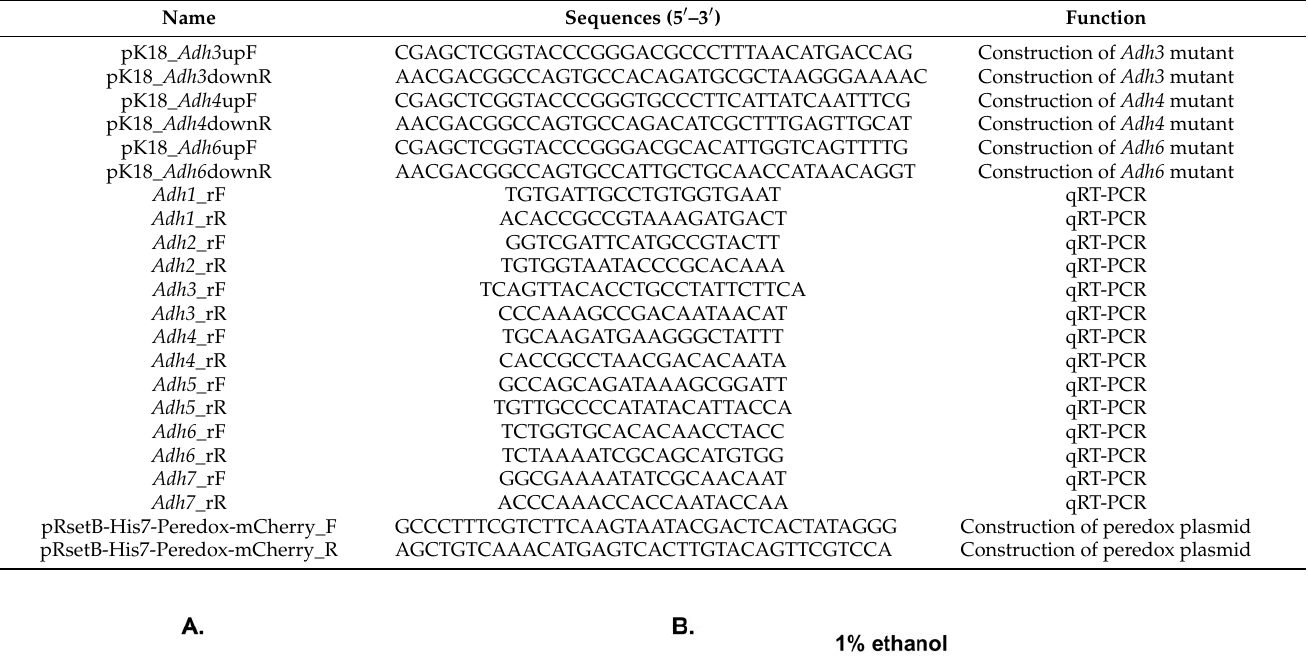
Table 2. Gene-specific primers used in this study.